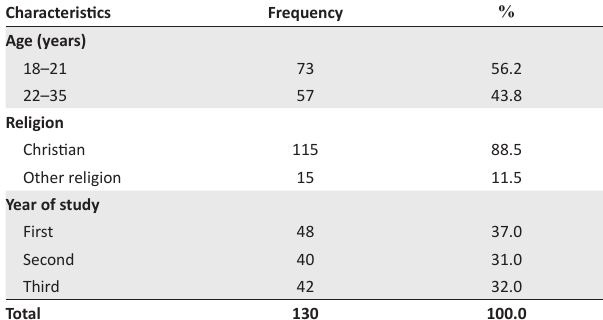
TABLE 1: Characteristics of the participants. Characteristics